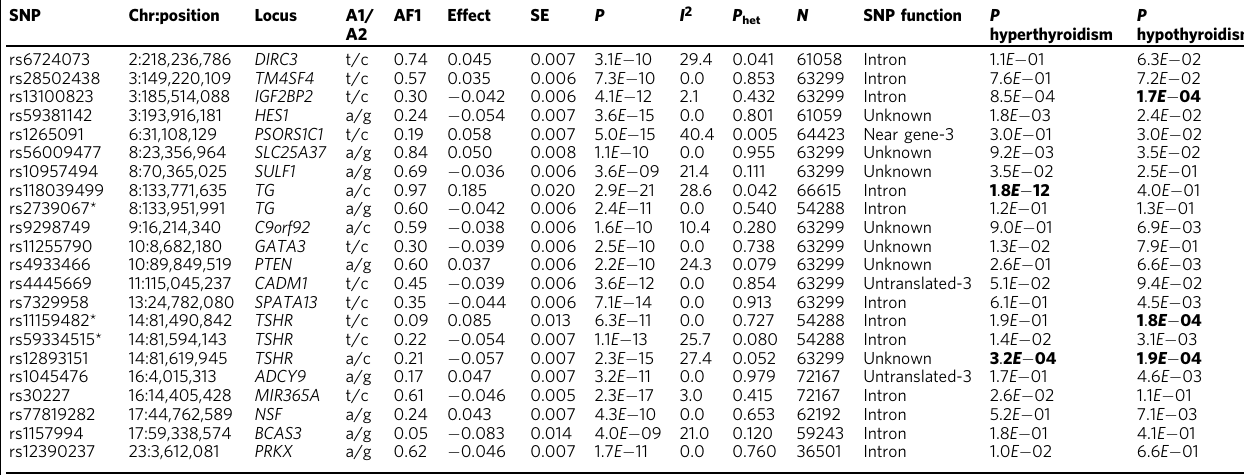
Table 1 Novel GWAS loci associated with TSH SNP